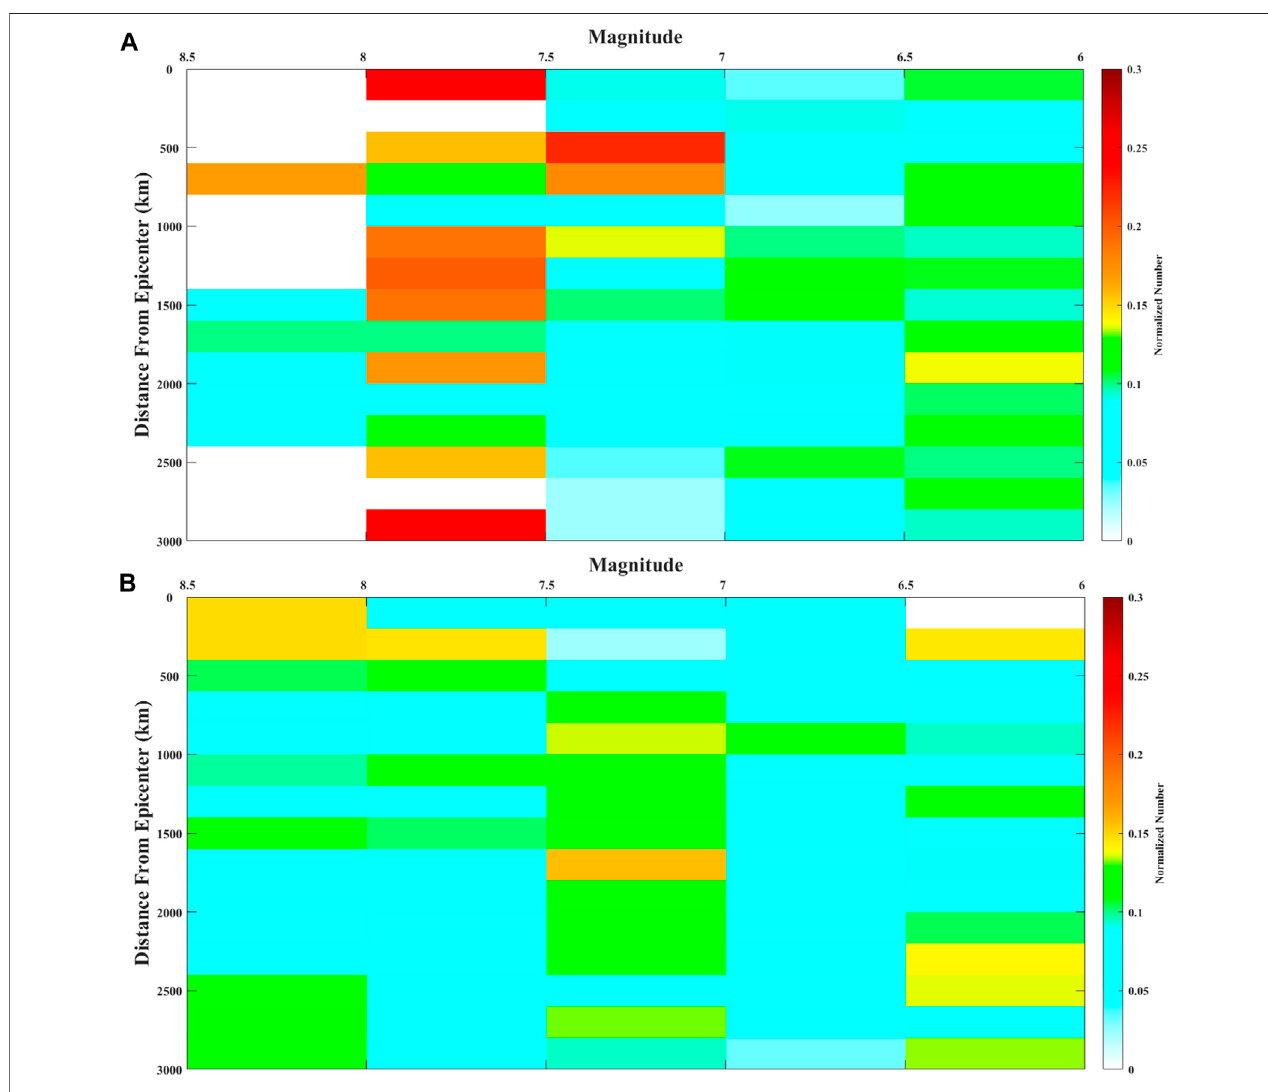
FIGURE 12 | Statistical result of seismo-ionospheric disturbances with the seismic magnitude ( X -axis) and distance from the epicenter ( Y -axis) by SESA. (A,B) Statistical results of real and random earthquakes, respectively. The color represents the normalized number by SESA, which is illustrated in the text.